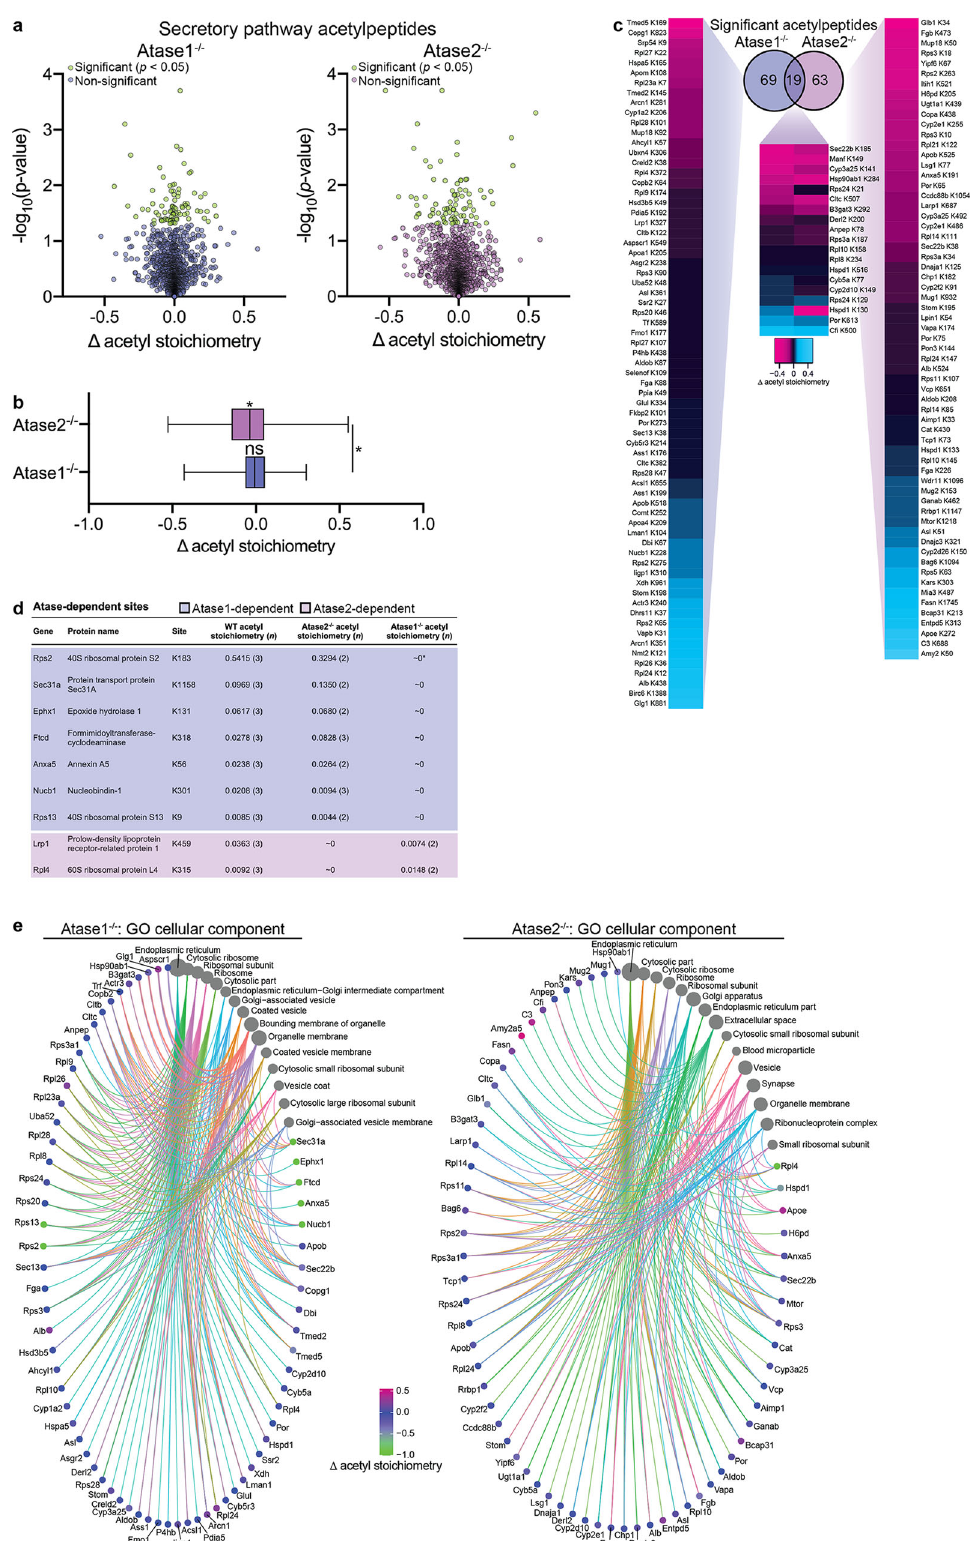
observed changes in stoichiometry of acetylation both within and outside the secretory pathway with substantial overlap between Atase1 − / − and Atase2 − / − mice. Indeed, we only observed a handful Atase-dependent sites that are likely to only be substrates of Atase1 or Atase2, thus con fi rming that the vast majority of N ε - lysine acetylation in the ER can be carried out by both Atase1